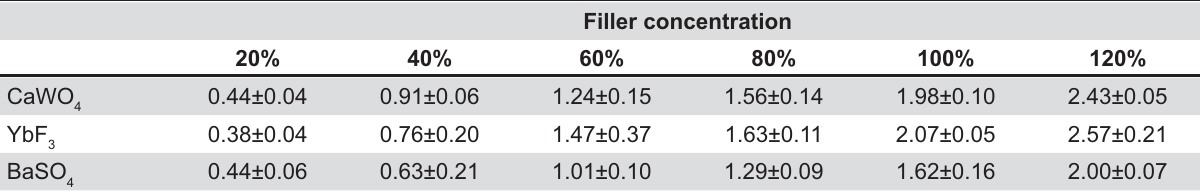
Table 2- Means ± standard deviation for the radiopacity (mmAl) of experimental sealers*